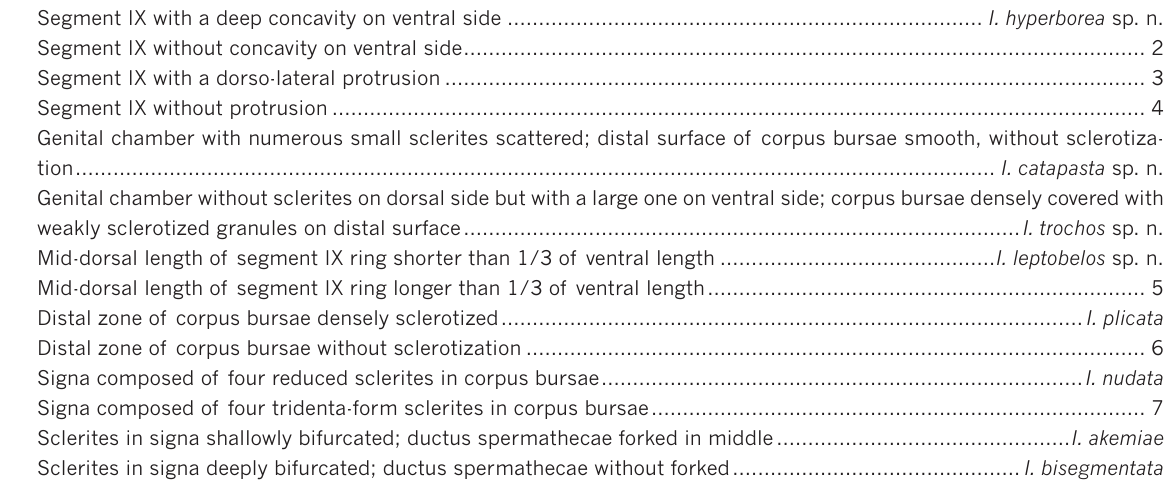
Additional sampling records of micropterigids in the Northeastern Japan All specimens described below are stored in KUHE.